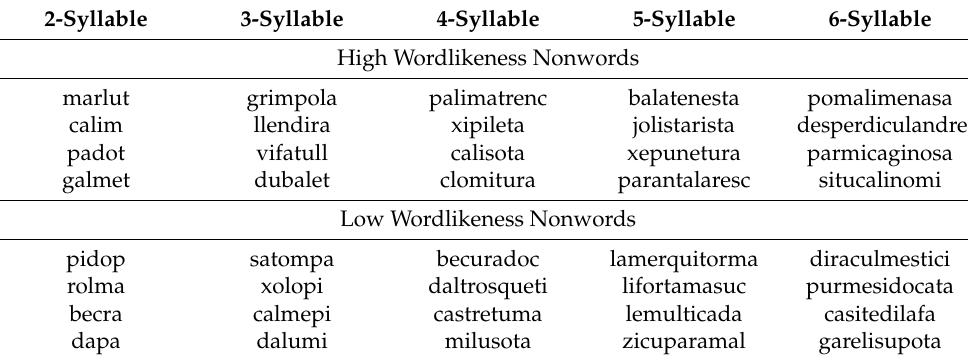
Table 2. The nonwords for the Catalan version of the nonword repetition task (NRT-Cat) by syllable length and